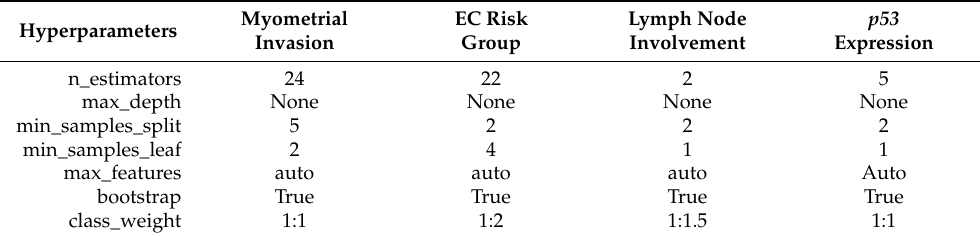
Table 5. Hyperparameters selected for the implementation of the four Random Forest Classifier (RFC)